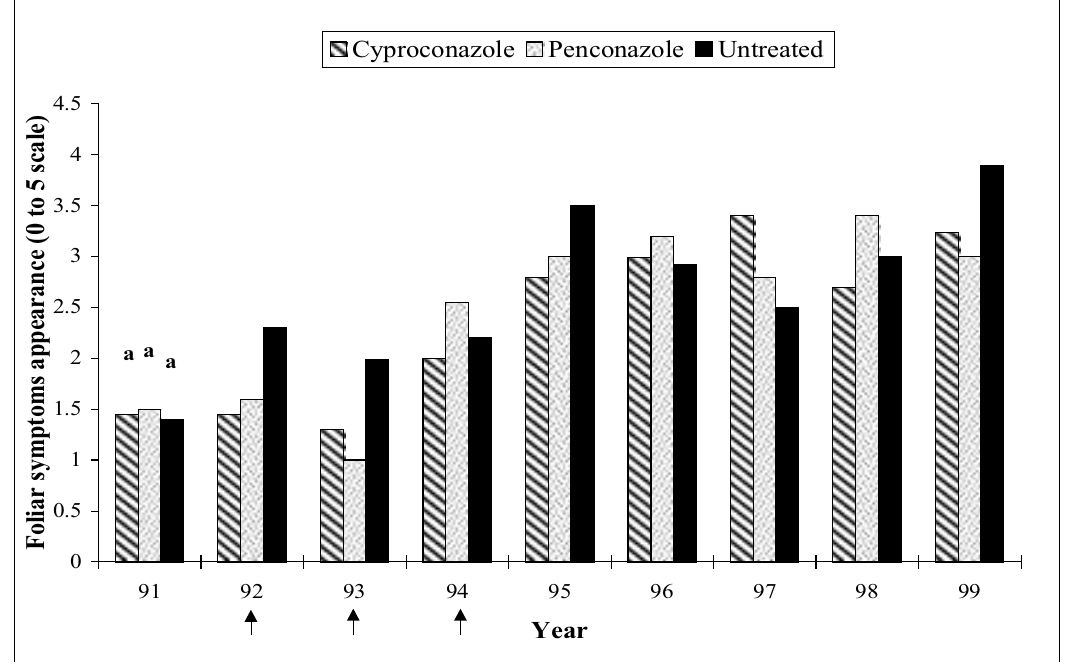
Fig. 3. Syringe field trial (cv. Cabernet-Sauvignon). Black arrow means fungicide application. For each year values are not statistically different ( P =0.05) according to Duncan’s multiple range.